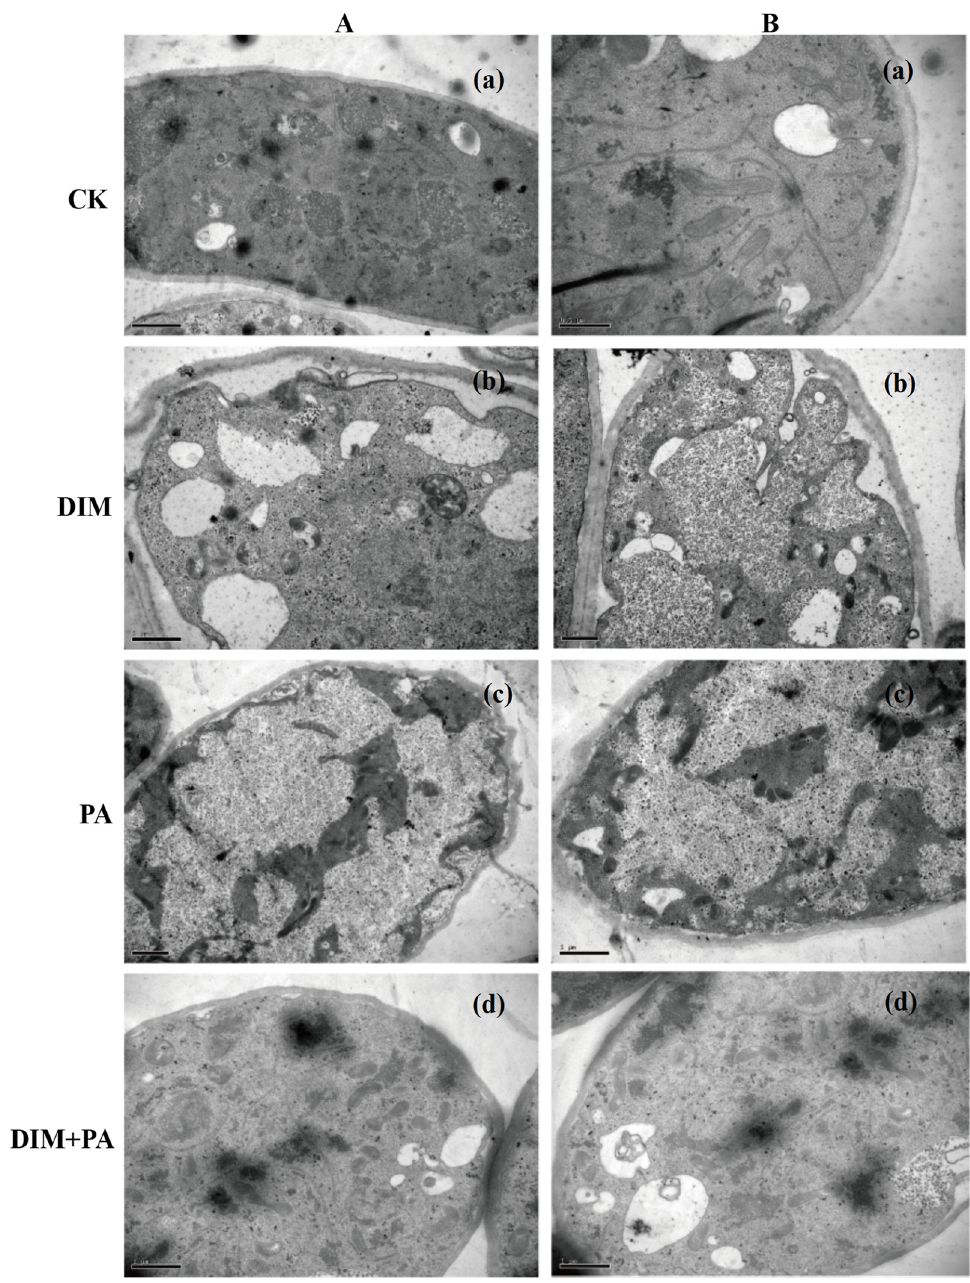
Figure 5. Effect of DIM or PA treatments on ultrastructural changes of sclerotia. Representative transmission electron microscopy (TEM) images of sclerotia cells selected from 2 specimens ( A , B ) in each treatment. Bar = 1 μ m. The treatments were: ( a ): CK, ( b ): DIM (0.8 mg·L − 1 ), ( c ): PA (0.1 ( A , B ) in each treatment. Bar = 1 µ m. The treatments were: ( a ): CK, ( b ): DIM (0.8 mg · L − 1 ), ( c ): PA mg·mL − 1 ), and ( d ): DIM (0.8 mg·L − 1 ) + PA (0.1 mg·mL − 1 ), respectively. (0.1 mg · mL − 1 ), and ( d ): DIM (0.8 mg · L − 1 ) + PA (0.1 mg · mL − 1 ),